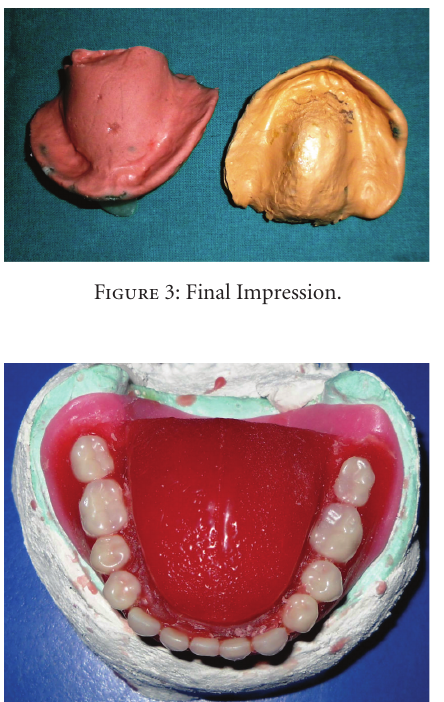
Figure 4: Wax up trial of tongue prosthesis.